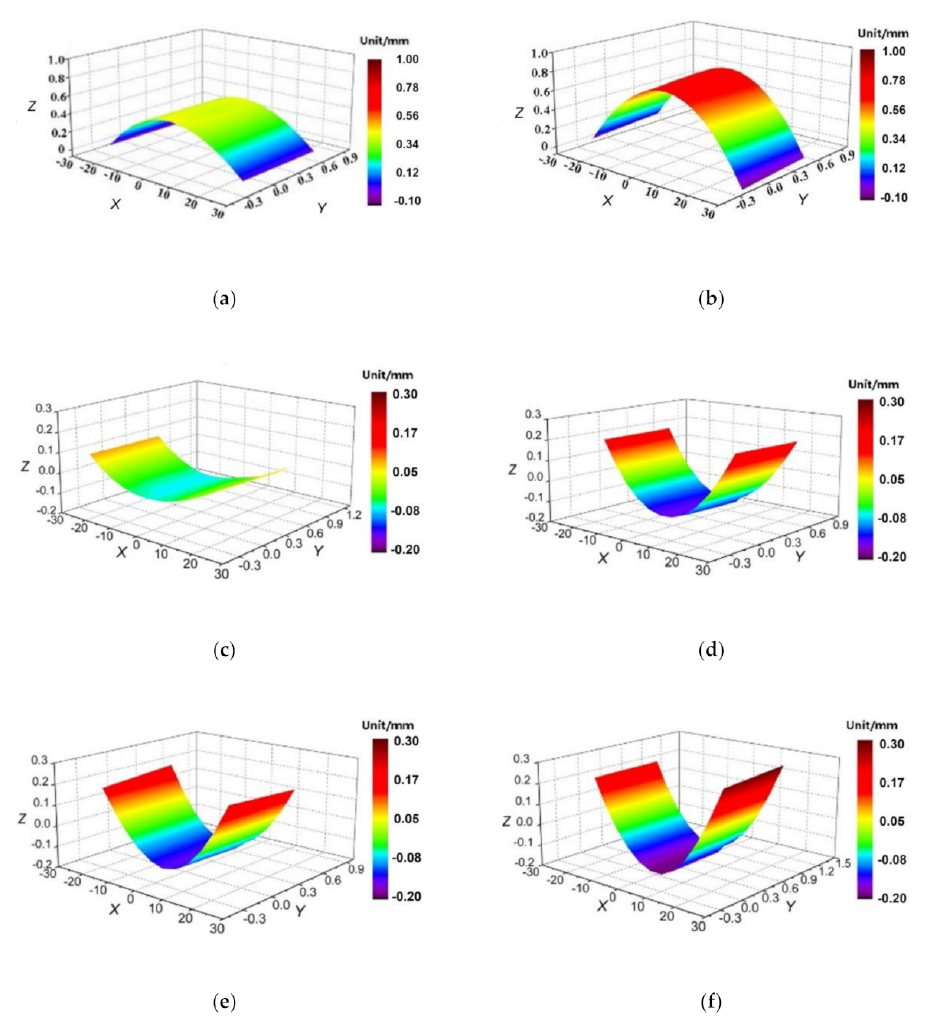
Figure 9. Morphology contours of TBC specimens: ( a ) before topcoat deposition; ( b ) as received; ( c ) high temperature exposure for 2 h; ( d ) high temperature exposure for 5 h; ( e ) high temperature exposure for 10 h; ( f ) high temperature exposure for 20